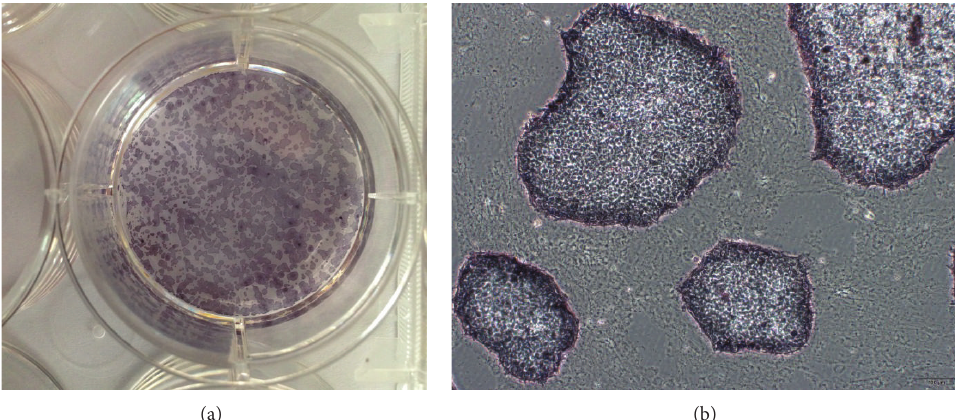
Figure 4: hESCs cultured on fixed xeno-free ECM at passage 25 were positive for AP. (a) Overview appearance of hESC colonies with AP staining on 6-well plate; (b) morphology of hESCs under the microscope after AP staining